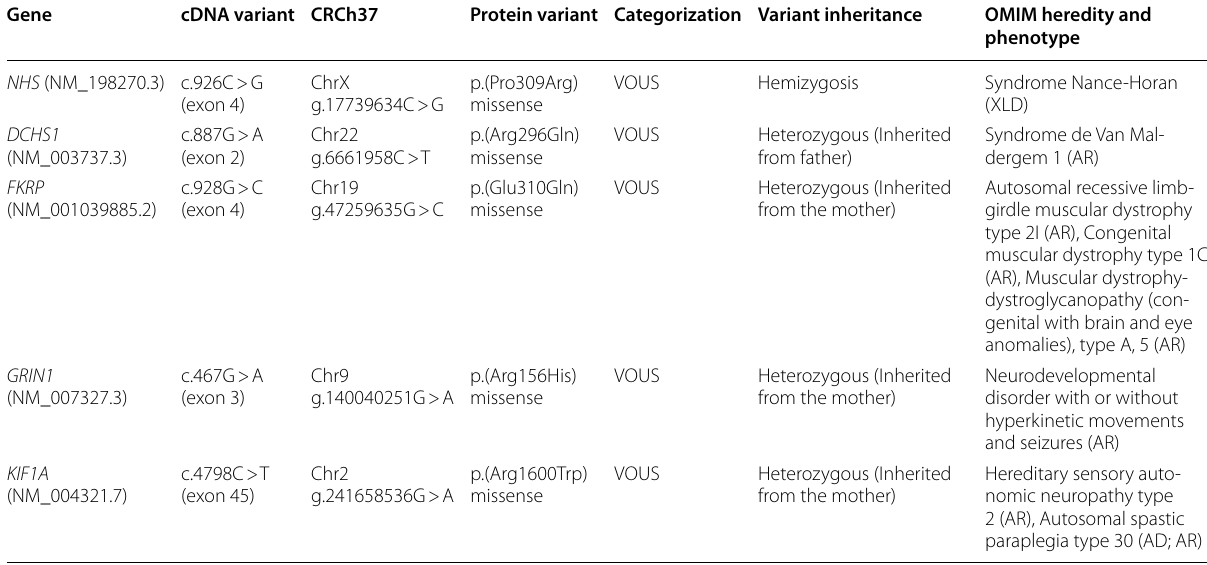
XLD X-linked dominant, AR autosomal recessive, AD autosomal dominant, VOUS variant of uncertain significance